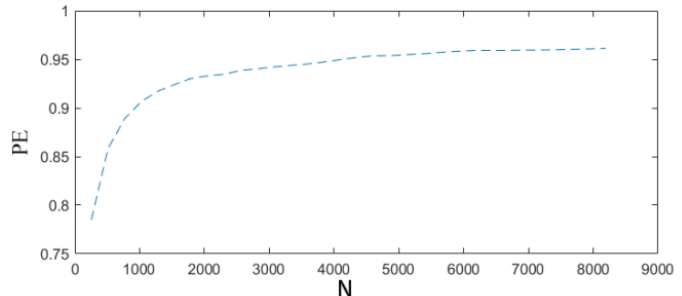
Figure 9. Alignment entropy variation curves for different signal lengths.